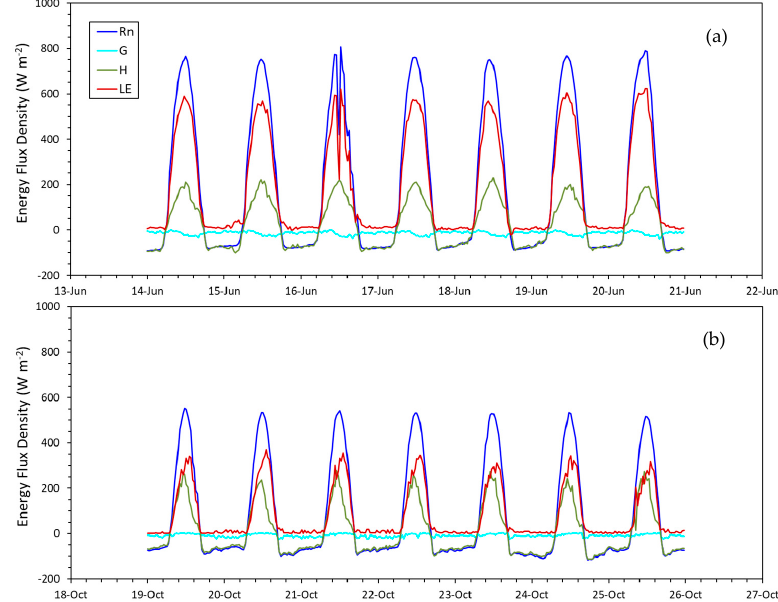
Figure 7. Half-hourly net radiation (Rn), sensible heat flux density (H), ground heat flux density (G), and latent heat flux density (LE) in a period of 7 days on ( a ) 14 June through 20 June